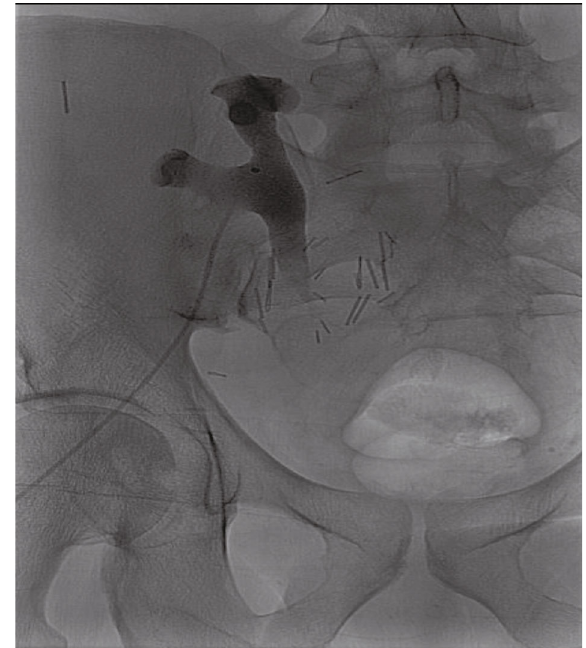
Figure 2: Postnephrostogram on readmission with no distal fl ow of contrast in the ureter.